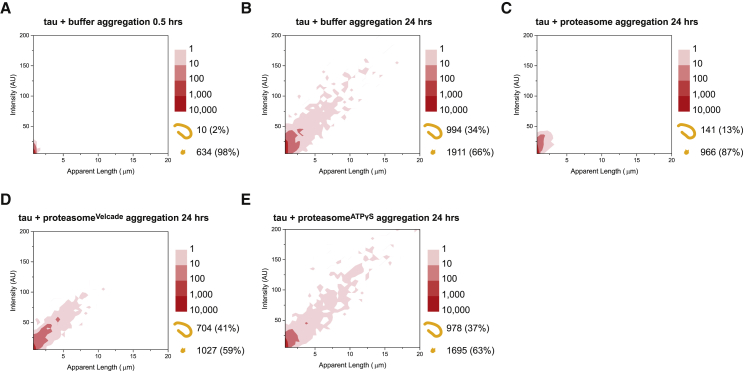
Aggregation of Tau in the Presence of Proteasome Holoenzymes(A and B) Monomeric tau proteins at 2 μM final concentration were mixed with proteasome buffer and imaged after (A) 0.5 h or (B) 24 h, showing a substantial increase in both fibril and small aggregate levels.(C–E) Aggregation of tau in the presence of 40 nM final concentration of (C) untreated, (D) Velcade-treated, and (E) ATPγS-treated proteasome holoenzyme, measured after 24 h of incubation.Each plot contains the cumulative data from three independent measurements (n = 3).